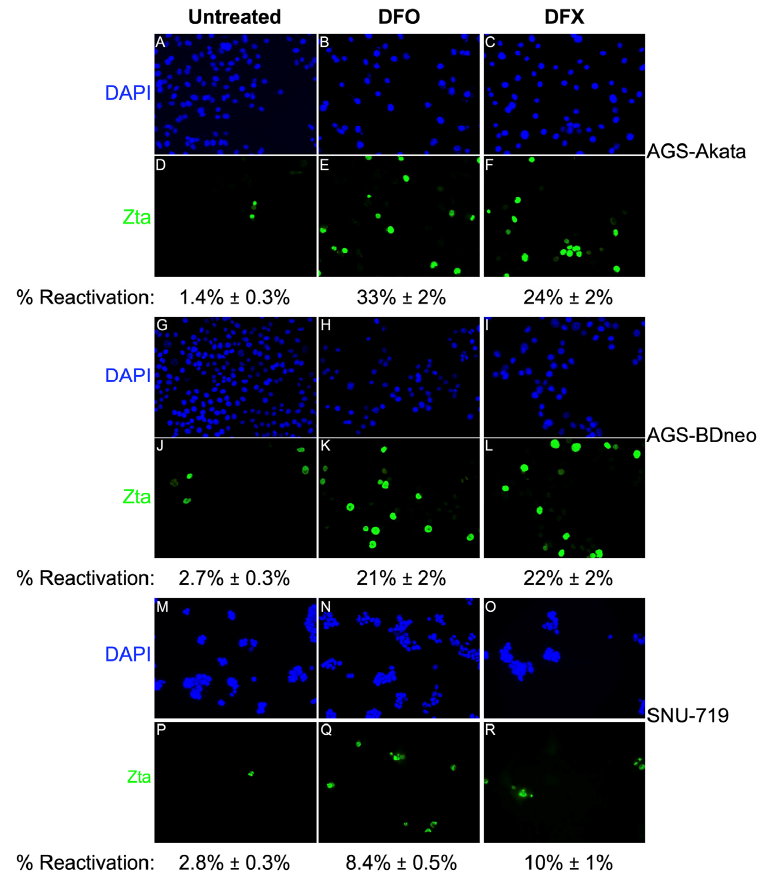
Figure 6. Efficiencies of viral reactivation following 24 h incubation of EBV(+) gastric cancer cells with a low dose of DFO or DFX. The cells were incubated for 24 h with 50 μΜ DFO ( B,E,H,K,N , and Q ) or 30 μ M DFX ( C,F,I,L,O , and R ). After removal of the drug, incubation was continued for another 24 h [AGS-Akata ( A – F ); AGS-BDneo ( G – L )] or 48 h [SNU-719, ( M – R )] prior to fixation and staining with DAPI (for nuclear DNA) and a Zta-specific antibody. Five-to-ten fields of cells were examined in each dish from 2–3 separate experiments to determine the mean percentages of Zta+ cells shown in representative images photographed at 20X magnification. Error bars represent ± S.E.M.; p ≤ 5 × 10 − 5 for treatment compared to control.